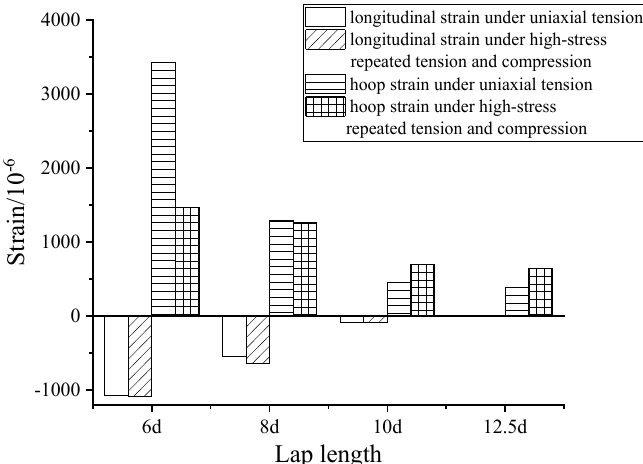
Figure 20. Effect of lapping length on the longitudinal and hoop strains of the middle section of the sleeve under the ultimate load during uniaxial tension and repeated tension and compression (only the final tension process) loading.